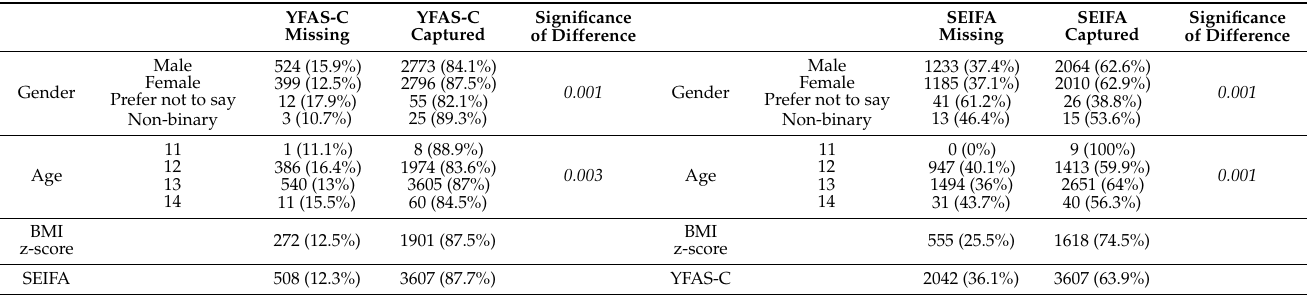
Table 1. Missing food addiction (YFAS-C) and Socio-economic Indexes for Areas scale (SEIFA) data reported as frequency (%).